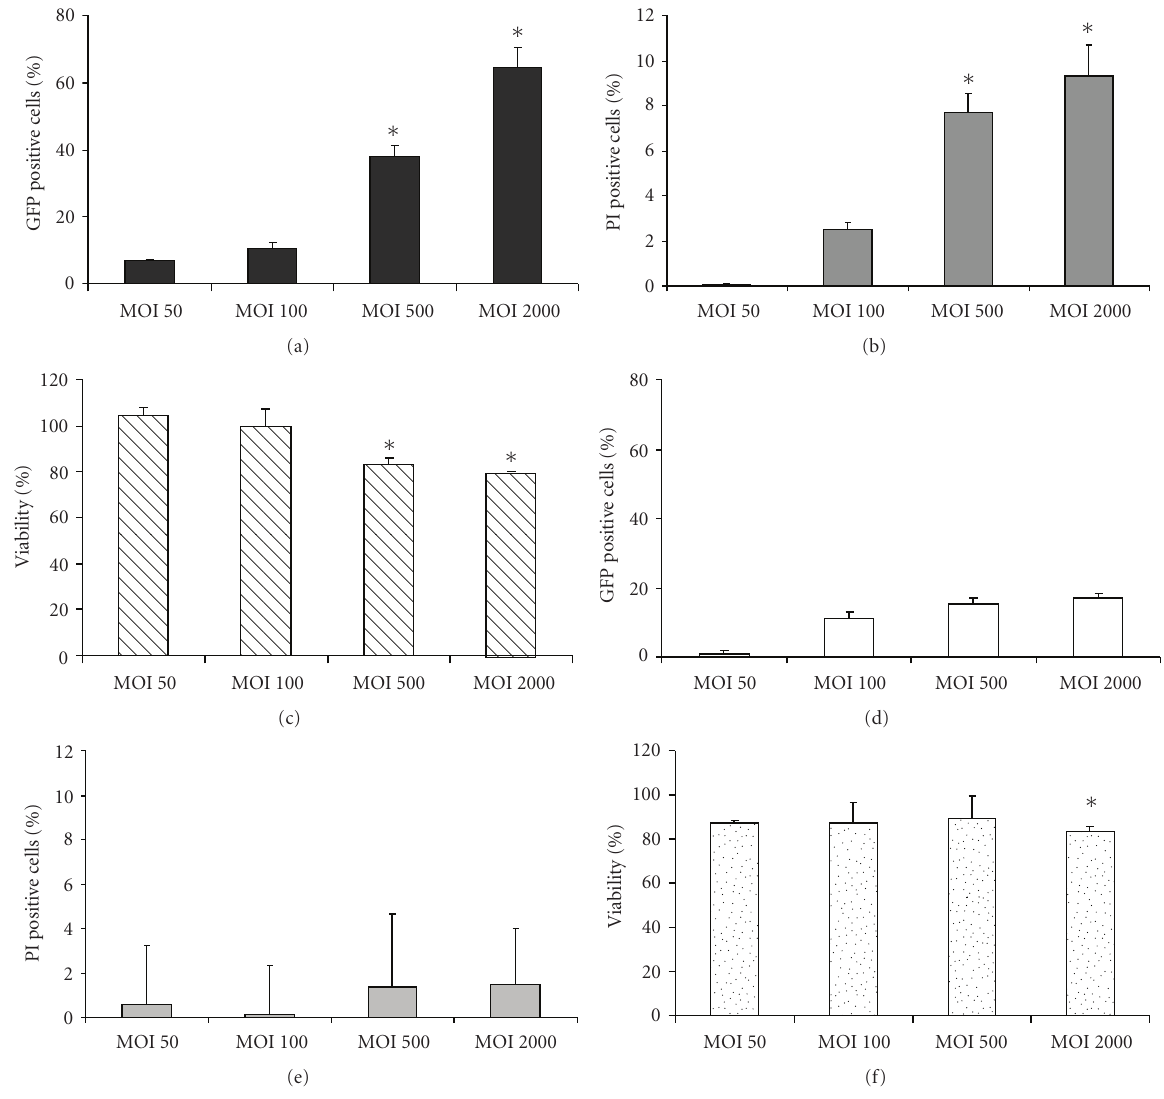
Figure 1: E ffi ciency and cytotoxicity of LV transduction . Polarized 16HBE41o- cells were incubated with di ff erent MOIs for 24 (a, b, and c) or 4 (d, e, and f) hours and then analyzed either immediately for membrane permeability (b and e) and viability (c and f) or incubated for further 48 hours and evaluated for GFP expression (a and d). Percentage of propidium iodide (PI)-positive cells incubated with medium only was 3.45 ± 0.28% and subtracted from the other values. In the viability assay, untreated cells were incubated with medium only and considered as 100%. Data are expressed as means ± SD of two-three experiments. A and B: ∗ P < . 05 for 500 and 2000 MOIs versus 50 and 100 MOIs. C and F: ∗ P < . 05 for 500 and 2000 MOIs versus